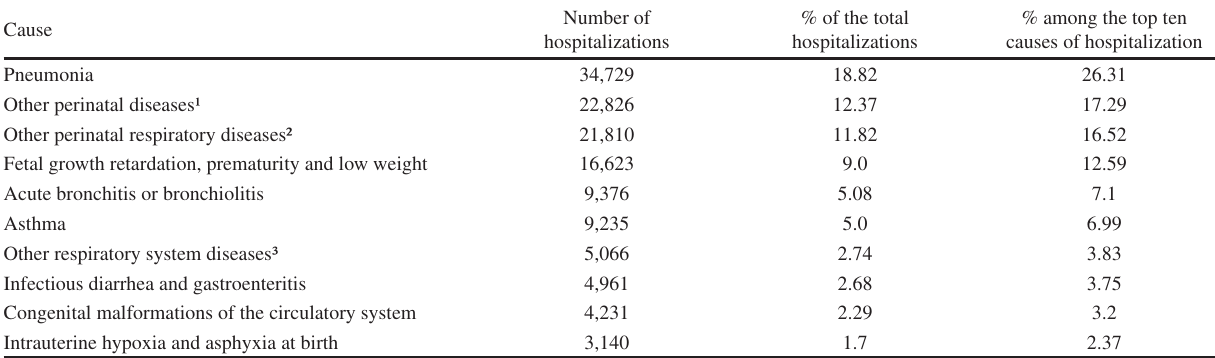
Table 1 - The top ten causes of hospitalization in children younger than one year of age, in the city of São Paulo, during the five years studied, 2002 to